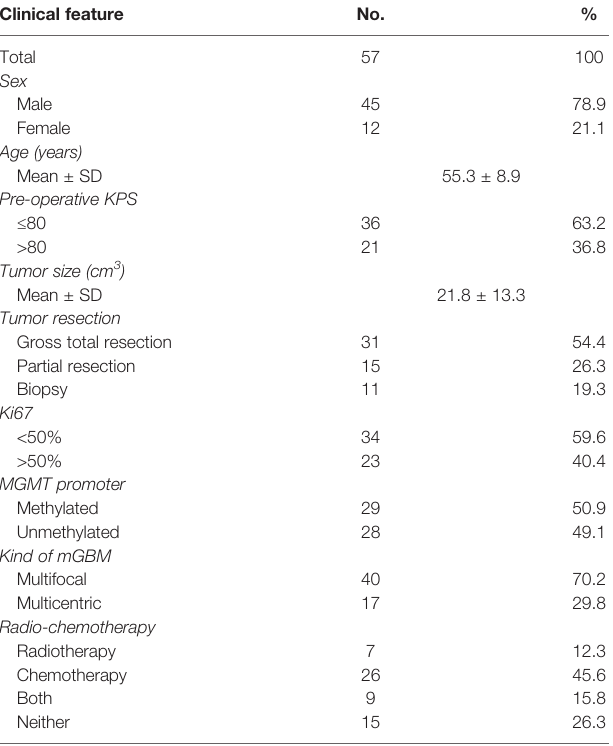
TABLE 1 | Clinical feature of the 57 multifocal and multicentric glioblastomas. Clinical